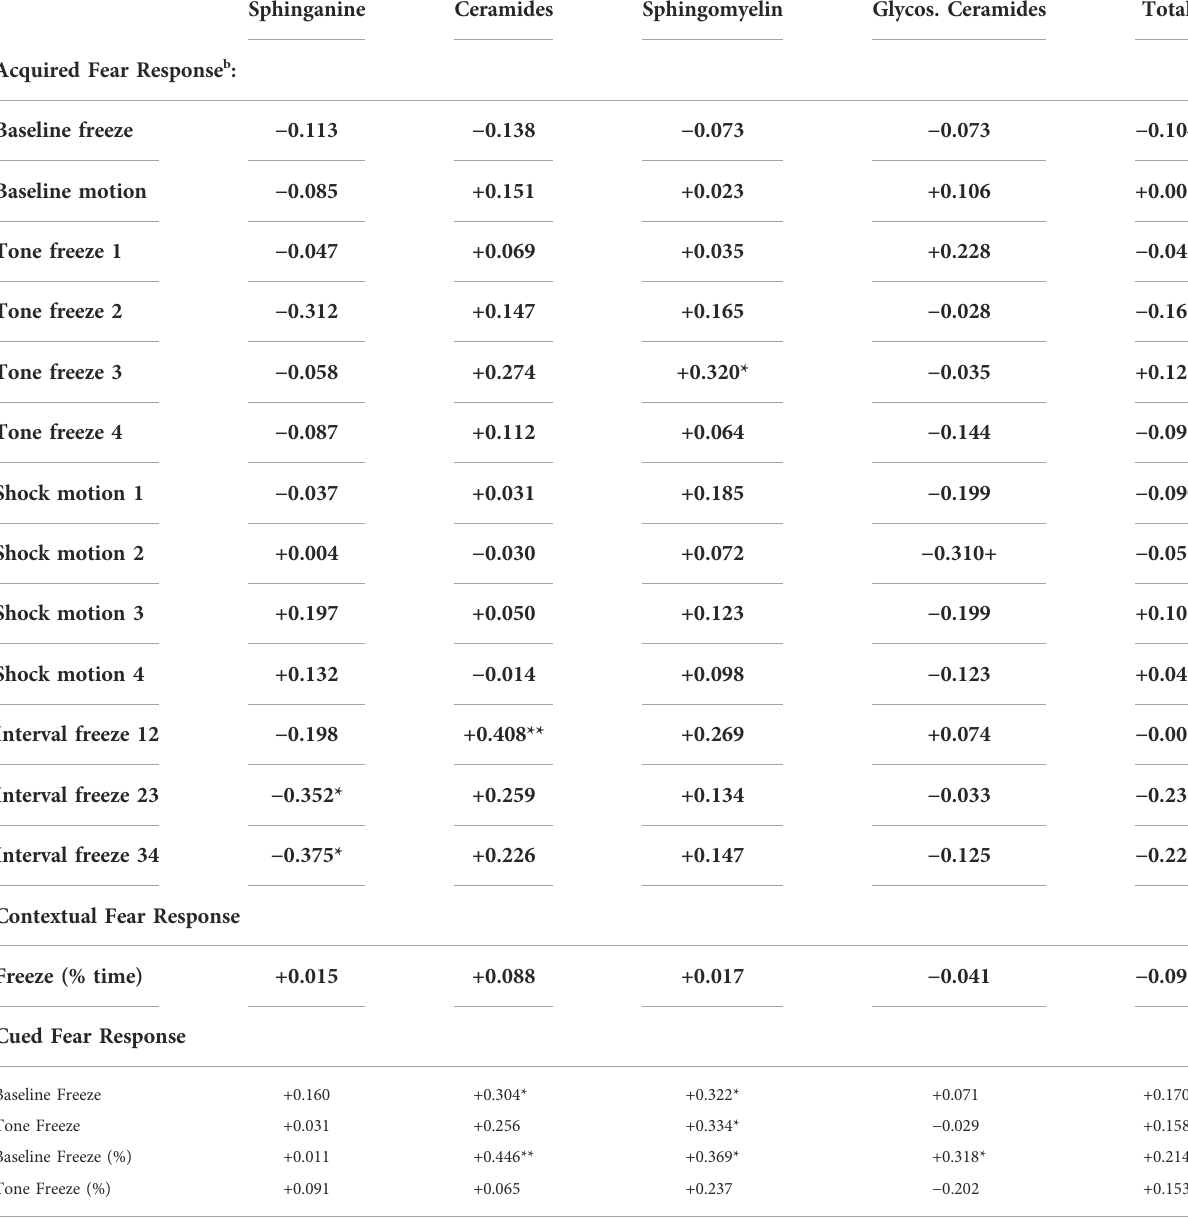
protein levels in the hippocampus (sign test: p = 0.0005), and in 10 of 12 comparisons, E4 mice had lower glucose transporter protein levels in the cortex ( p = 0.04) than WT mice. Similarly, E3 mice had higher glucose transporter protein levels in the hippocampus and lower glucose transporter protein levels cortex than WT mice. In 10 of 12 comparisons, E4 mice had higher glucose transporter protein levels in the hippocampus (sign test: p = 0.04) and lower glucose transporter protein levels in the